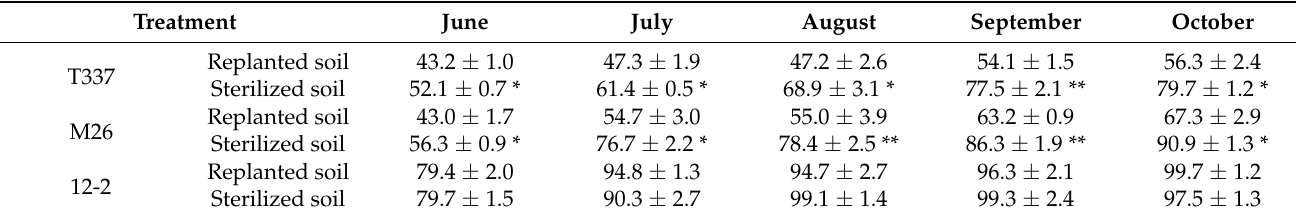
Table 1. The height (cm) of the plants with different rootstock types planted in sterilized and replanted soil. Treatment